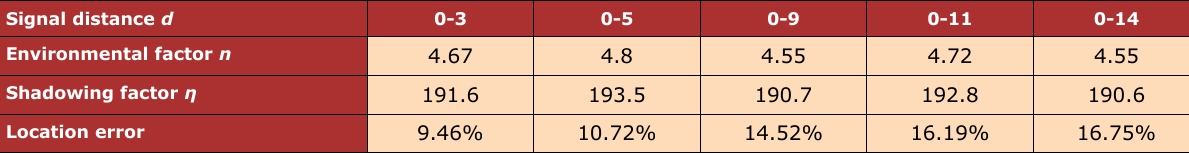
Table 2. Fitting model in continuous